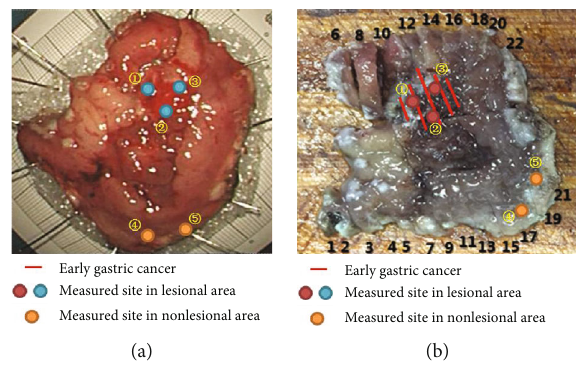
Figure 3: An EGC ESD specimen: (a) fresh specimen without any processing; (b) specimen with its shape restored after histopathological sectioning, along with the measured sites ( ① – ⑤